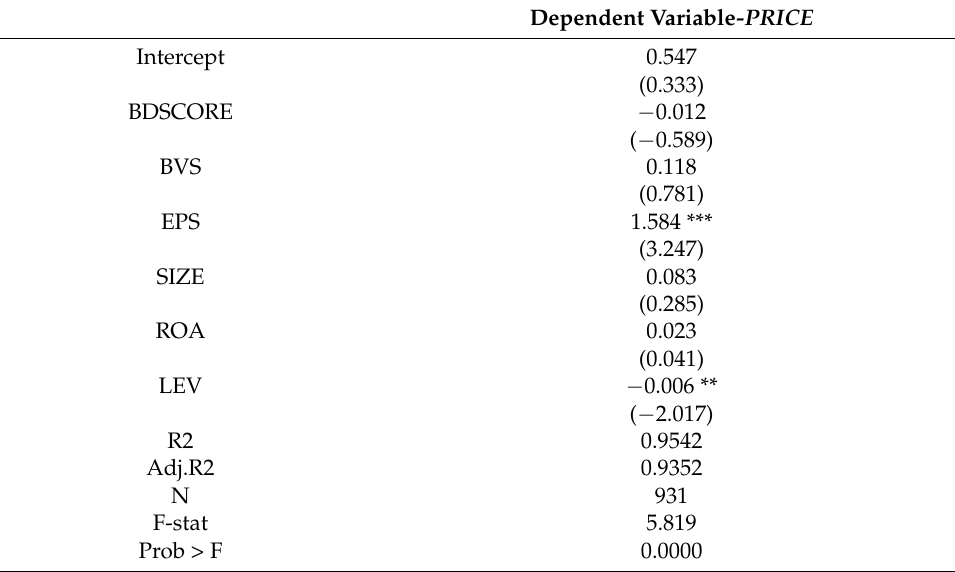
Table 10. Results of regression of board scores on PRICE